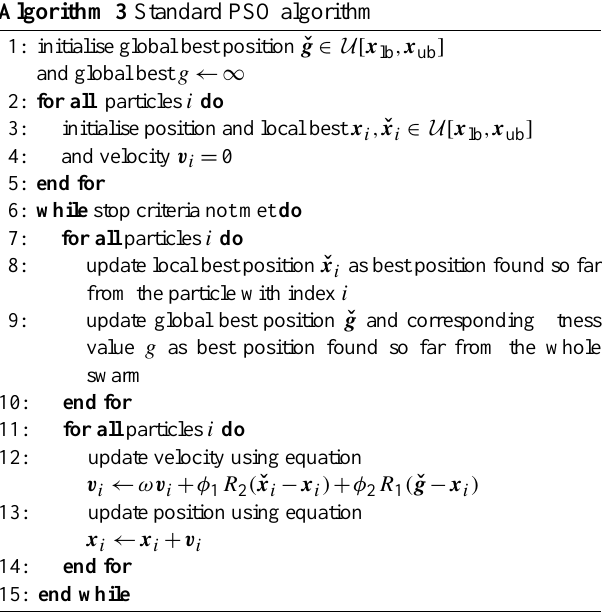
Algorithm 3 Standard PSO algorithm